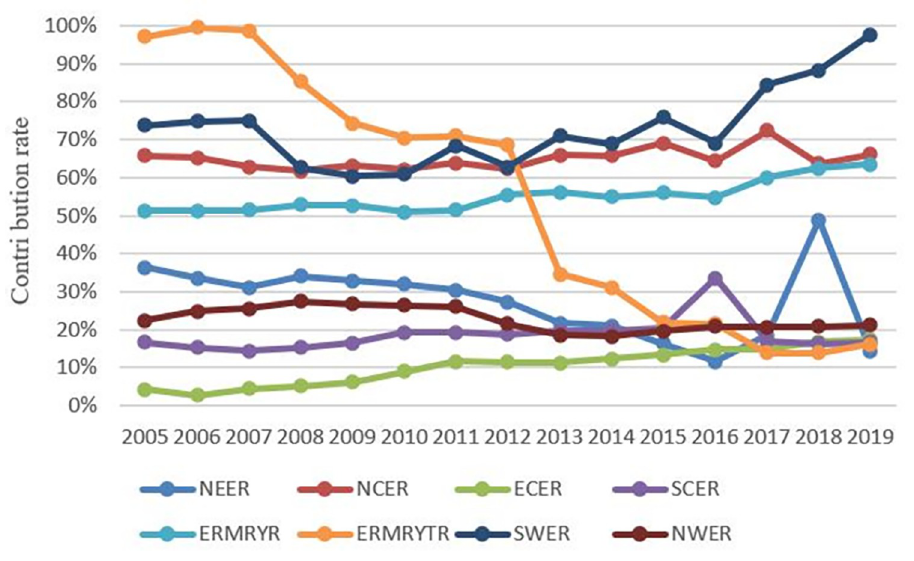
Fig 6. The contribution rate of intra-regional